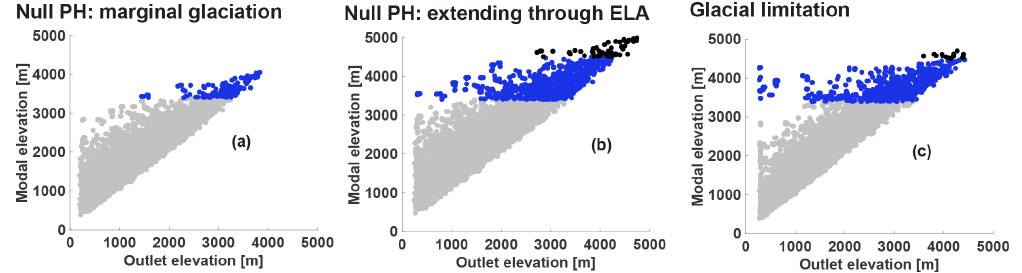
Figure 13. Progressive hypsometry for mountains uplifted through ELA and for glacial limitation. (a) Null model in which glacial erosion is either absent or negligible or, if present, has been largely destroyed by interglacial processes (to the extent that it is not recorded in the PH). (b) As rock mass continues to rise through the ELA, glacial erosion is still unable to leave a lasting PH record, either due to its limited efficacy or because of effective scarp encroachment. (c) Glacial limitation: continued uplift through the ELA results in the growth of landscapes at the ELA and the establishment of a permanent glacial base level. Glacial landscapes are preserved enough to leave a strong signal of glacial limitation in